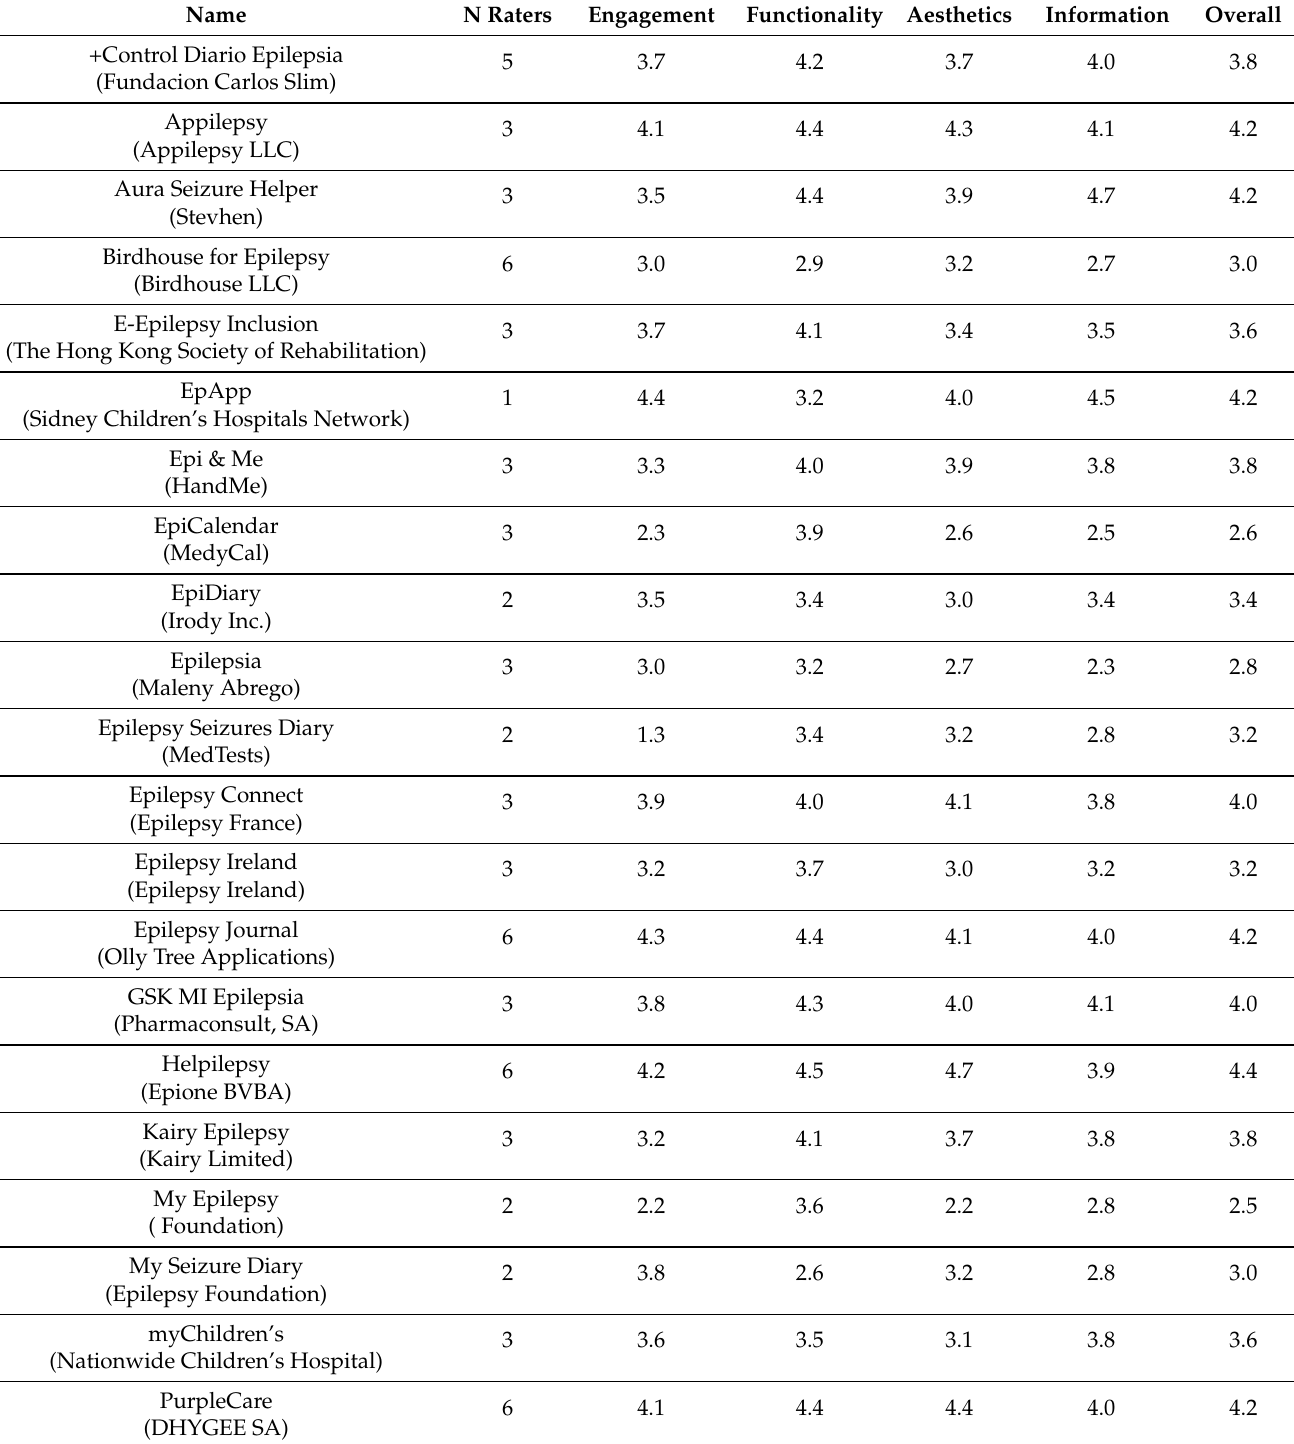
Table A4. Epilepsy applications evaluated with